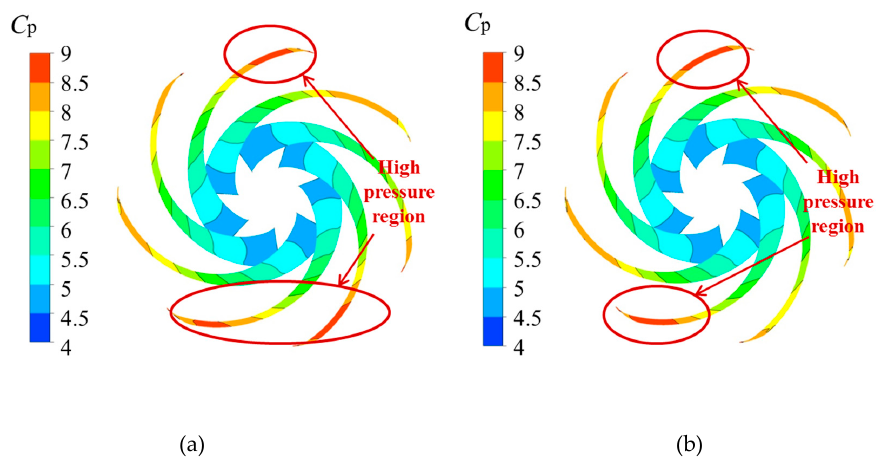
Figure 16. Instantaneous pressure distributions on the pressure side of the impeller at condition ( a ) IV and ( b ) III.